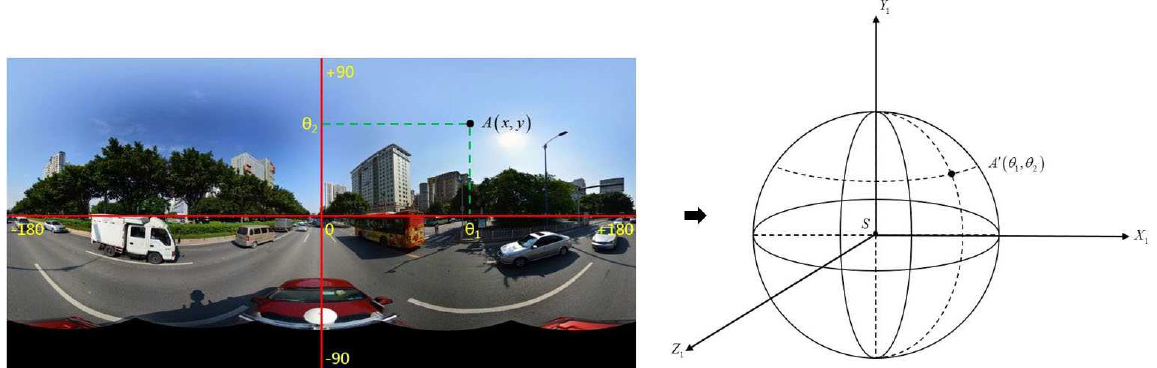
Figure 2. The perspective projection transformation from a cylindrical-projection panorama to a virtual sphere.